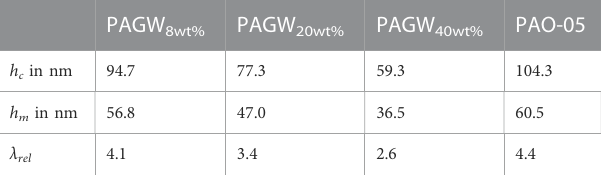
TABLE 4 Calculated central, minimum and relative fi lm thickness at v m = 1.0 m/s and p H = 1200 N/mm 2